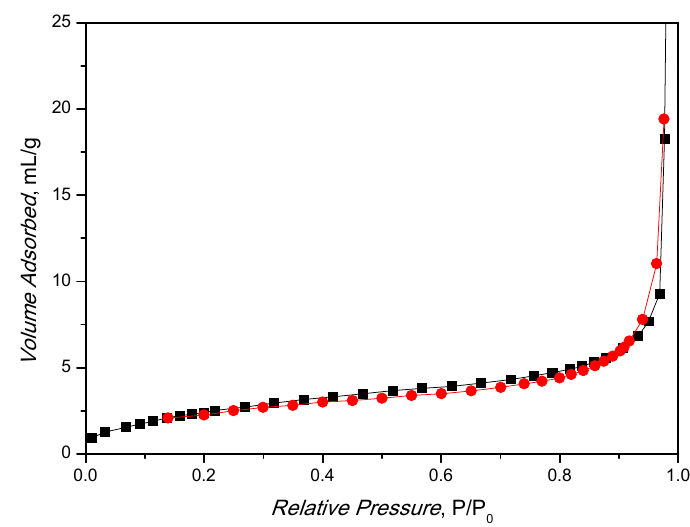
Figure 3. Nitrogen physisorption analysis of MIL-88A at T = 77K.